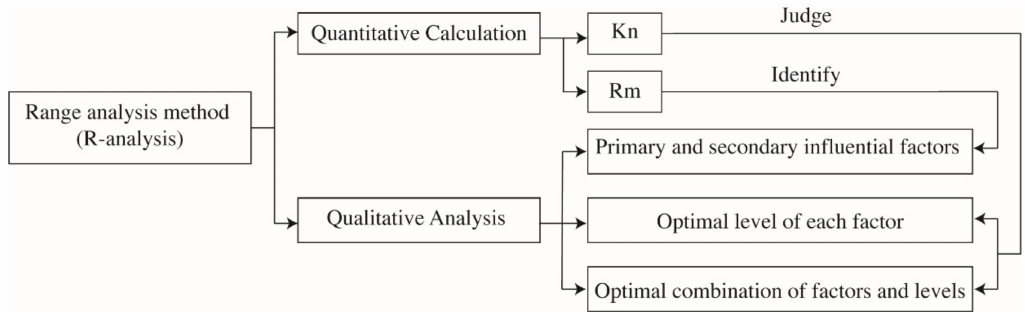
Figure 3. Schematic diagram of the range analysis